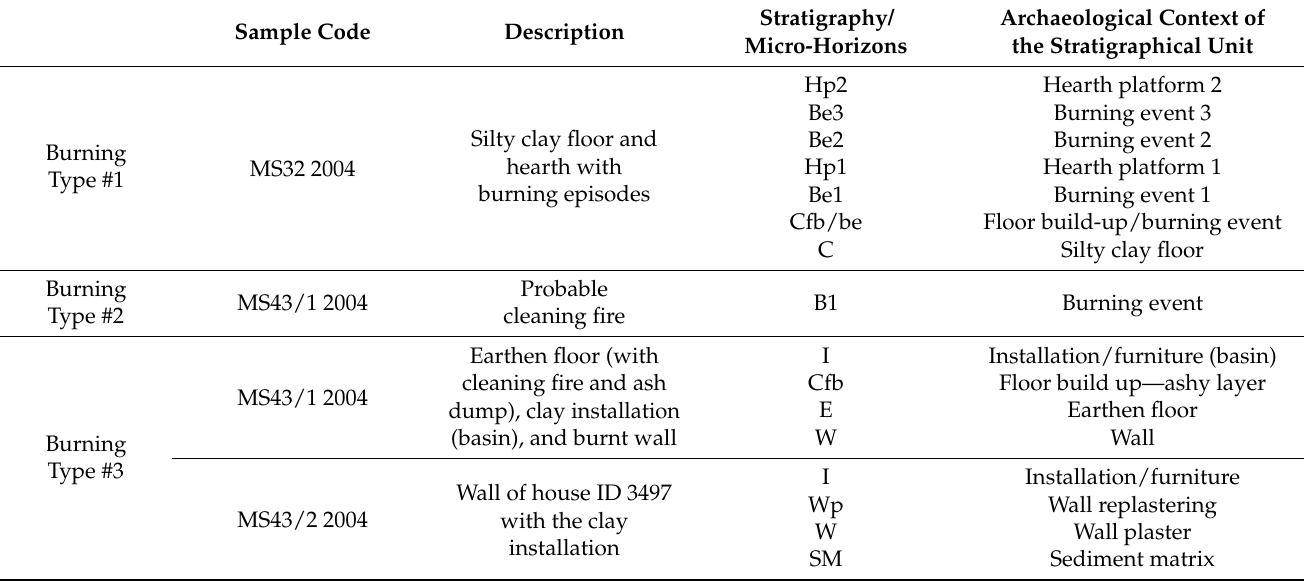
Figure 4. Locations of the origins of the thin-section soil micromorphological samples within house ID 3497. Table 1. Inventory of the investigated